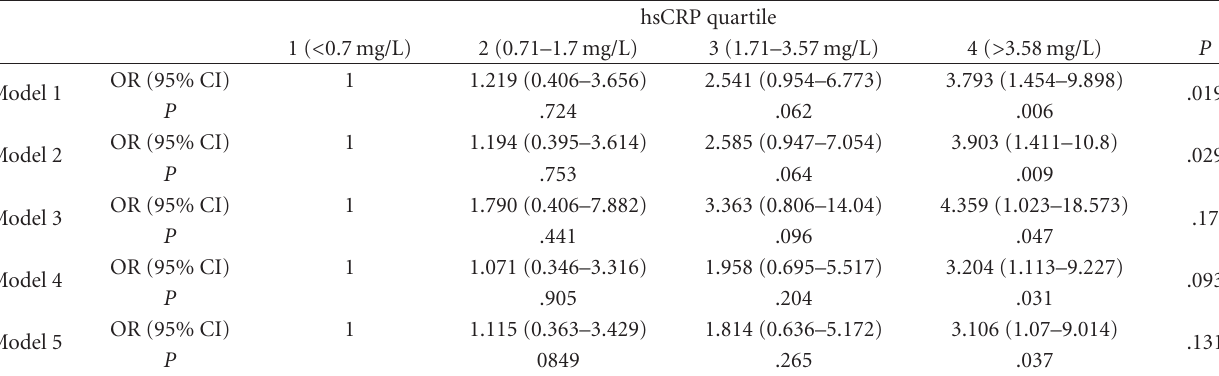
Table 4: Risk of recurrence of coronary artery disease (CAD) events based on high-sensitivity C-reactive protein (hsCRP)